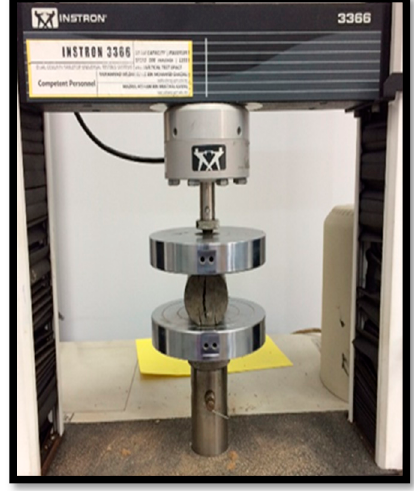
Figure 2. Indirect Tensile Strength Test.